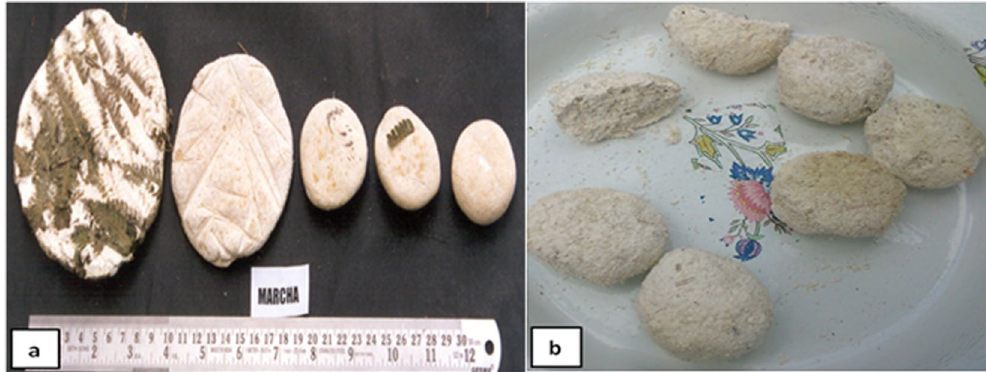
Figure 1. Traditionally prepared amylolytic starter cultures ( a ) Marcha and ( b ) Thiat .